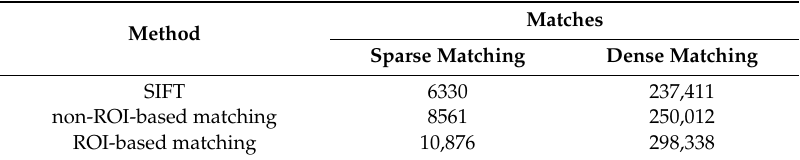
Figure 10. Results of sparse and dense matching in 3D space: ( a ) the overlapping images used; ( b ), ( c ), and ( d ) are the sparse point clouds obtained using SIFT, non-ROI-based matching, and ROI-based matching, respectively; ( e ), ( f ), and ( g ) are the dense point clouds corresponding to the results of ( b ), ( c ), and ( d ); the subregions marked by red are the low-quality 3D points. Table 3. Number of matches obtained using scale-invariant feature transform (SIFT), S-Harris-SIFT, and ROI-based S-Harris-SIFT, respectively.